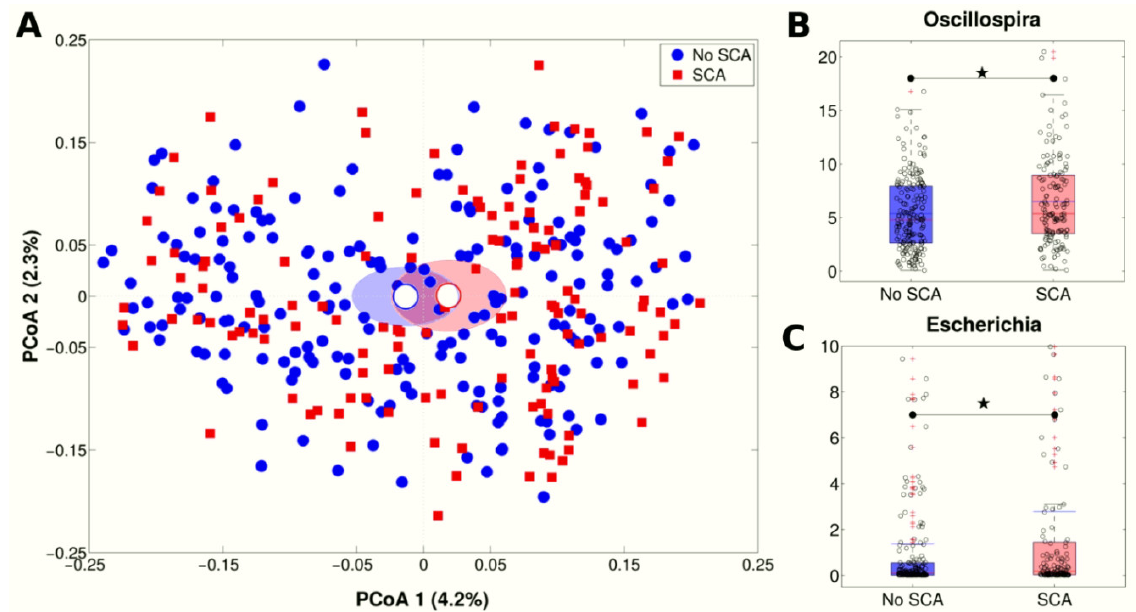
Figure 1. Taxonomic Gut Microbiota (GM) differences over SCA progression. ( A ) Principal Coordinate Analysis (PCoA) plot of the unweighted Unifrac distances; data were divided according to experimental category (SCA vs. no SCA); each point represents a sample; centroids are calculated as the mean coordinate of all samples per experimental category; ellipses represent the standard error of the mean (SEM)-based estimation of the variance. The first and second components of the variance are shown. ( B , C ) Boxplots of relative abundances of ( B ) Oscillospira and ( C ) Escherichia genera, according to SCA vs. no SCA experimental categories. Red lines indicate median and blue lines indicate mean values. Star indicates a significant difference ( p < 0.05, Mann-Whitney U-test).